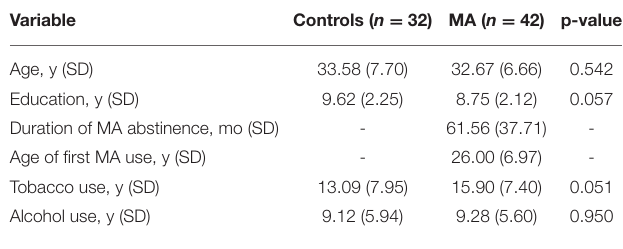
TABLE 1 | Enrolment criteria for MA abstainers and normal control groups.